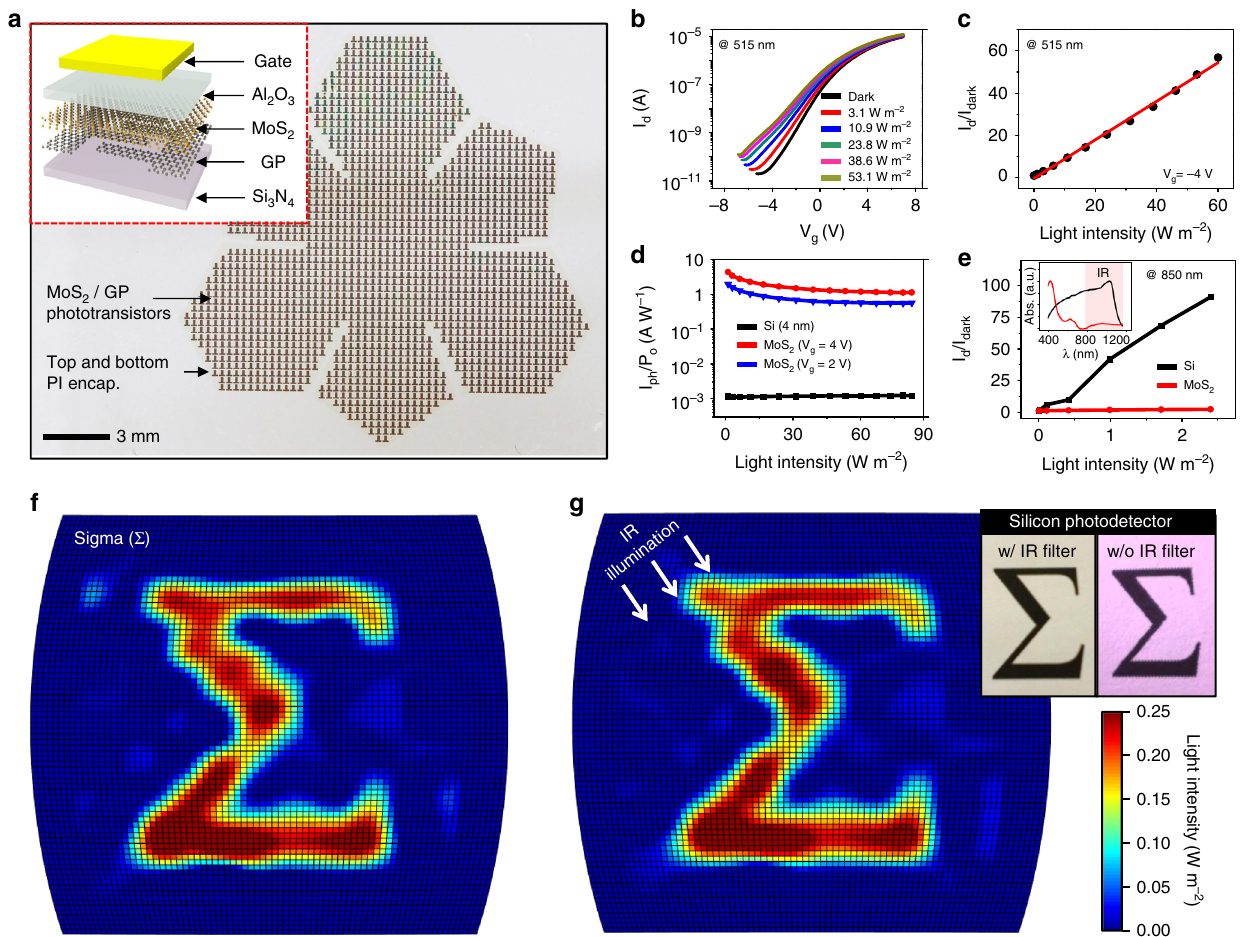
Fig. 3 Device characterization and imaging using the curved image sensor array. a The optical camera image of the phototransistor array with a truncated icosahedron design on a planar substrate. Inset shows a schematic illustration of the device structure. b Transfer curves of the phototransistor under different light (515 nm) intensities. c Normalized photocurrent change under different light intensities. d Photoresponsivity of the MoS 2 -graphene phototransistor compared to the silicon photodetector with the same thickness. e Normalized photocurrent change under IR illumination (850 nm) of different light intensities. Inset shows the light absorbance of MoS 2 and silicon. f Sigma-shaped image captured by the CurvIS array. g The same image with Fig. 3f but captured under IR illumination. Inset images are acquired by a commercial silicon photodetector array with (left) and without (right) an IR fi